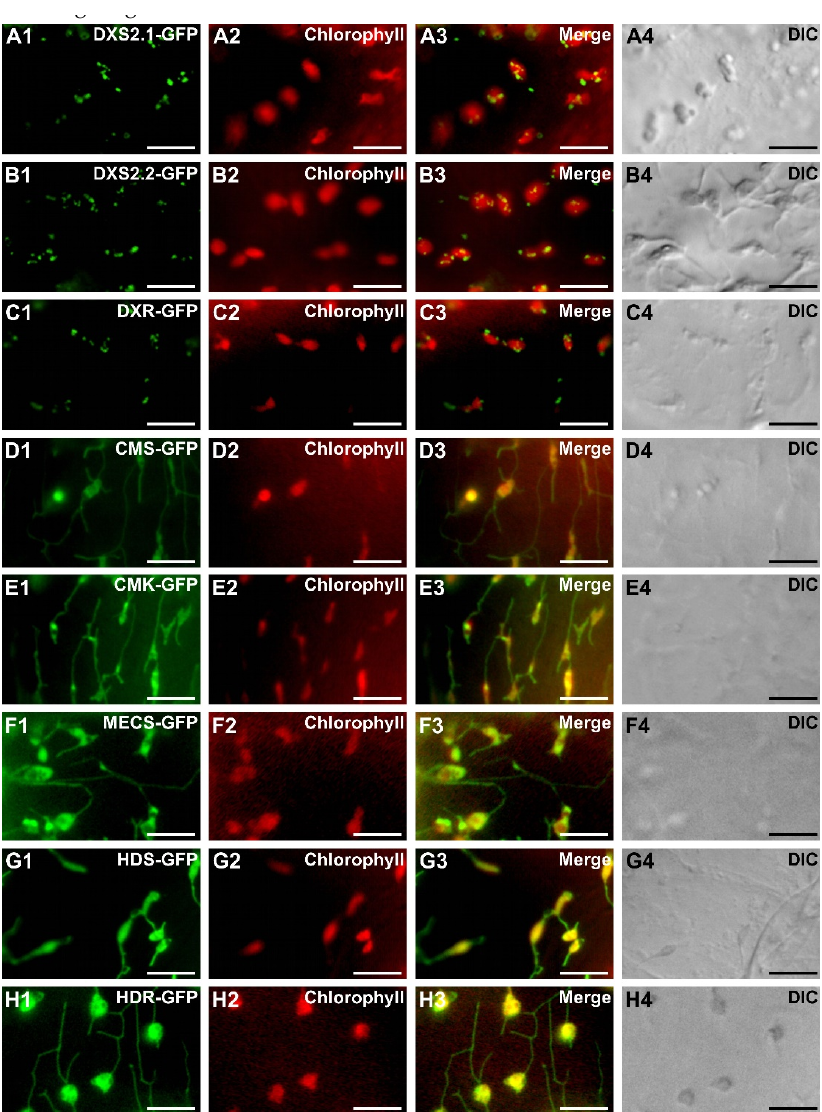
Figure 5. Subcellular localization of the MEP pathway enzymes in C. roseus chlorophyll-containing cells. C. roseus cells (CR6 cell line) were transiently transformed with plasmids expressing MEP pathway enzymes fused to the N-terminus of GFP as indicated in the first column. The fluorescence emitted by GFP-fused proteins ( A1 – H1 ) was compared to chlorophyll autofluorescence ( A2 – H2 ). Colocalization of the two signals appeared in yellow while merging the two individual (green / red) color images ( A3 – H3 ). Cell morphology was observed with di ff erential interference contrast (DIC, A4 – H4 ). Bar: 10 µ